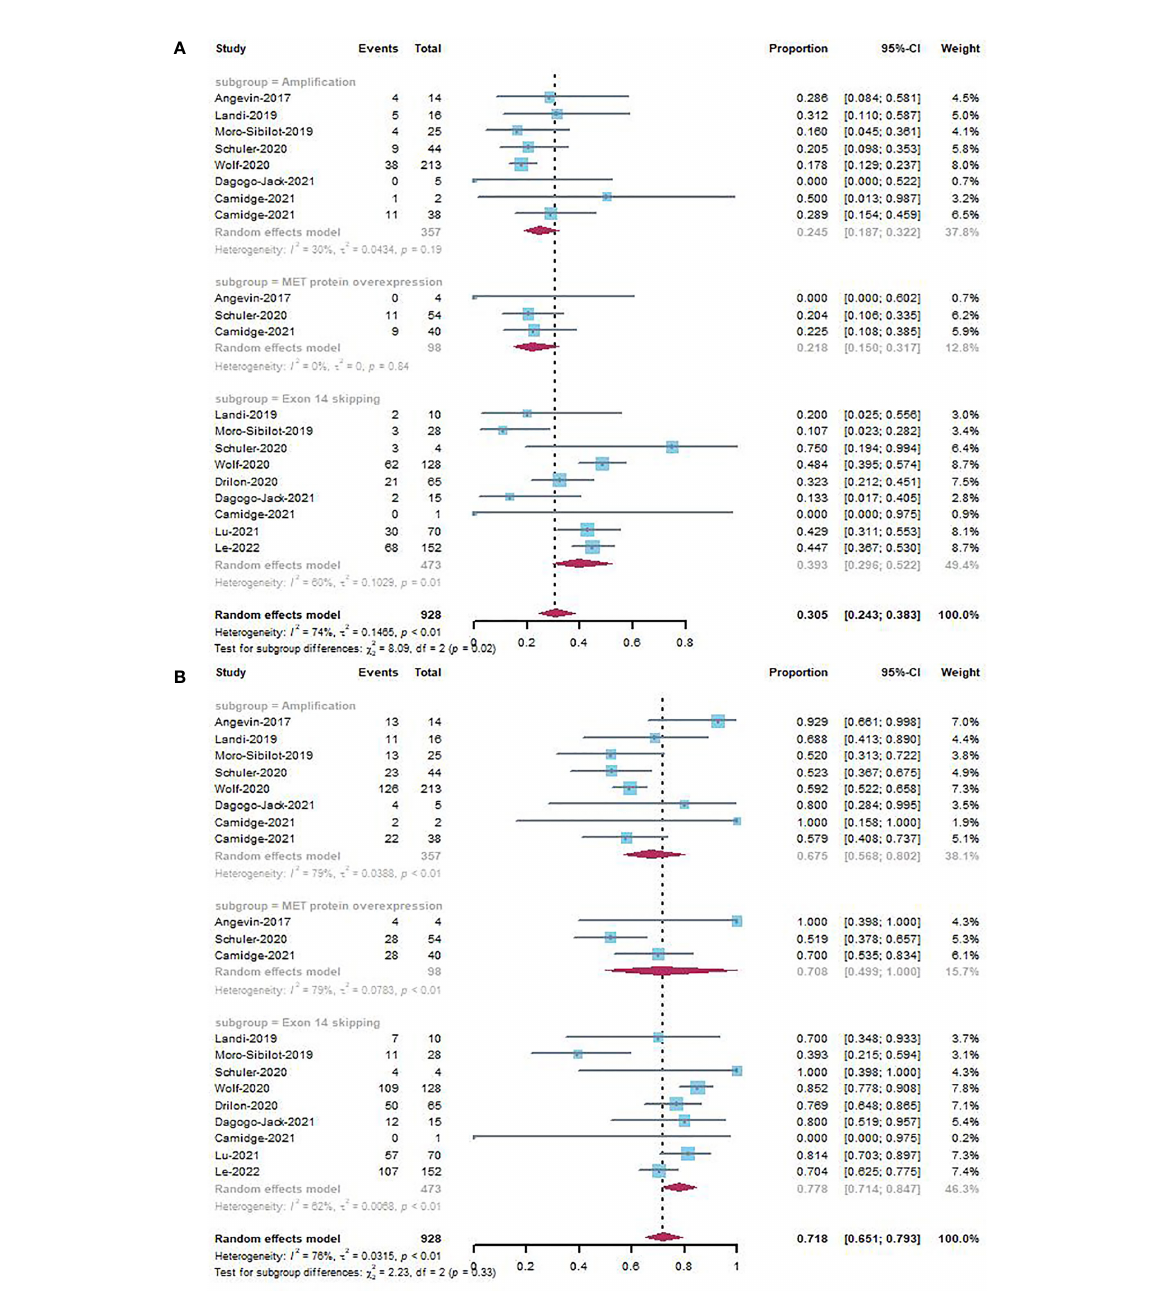
FIGURE 4 Subgroup analyses by different MET dysregulation of ORR (A) and DCR (B) in NSCLC